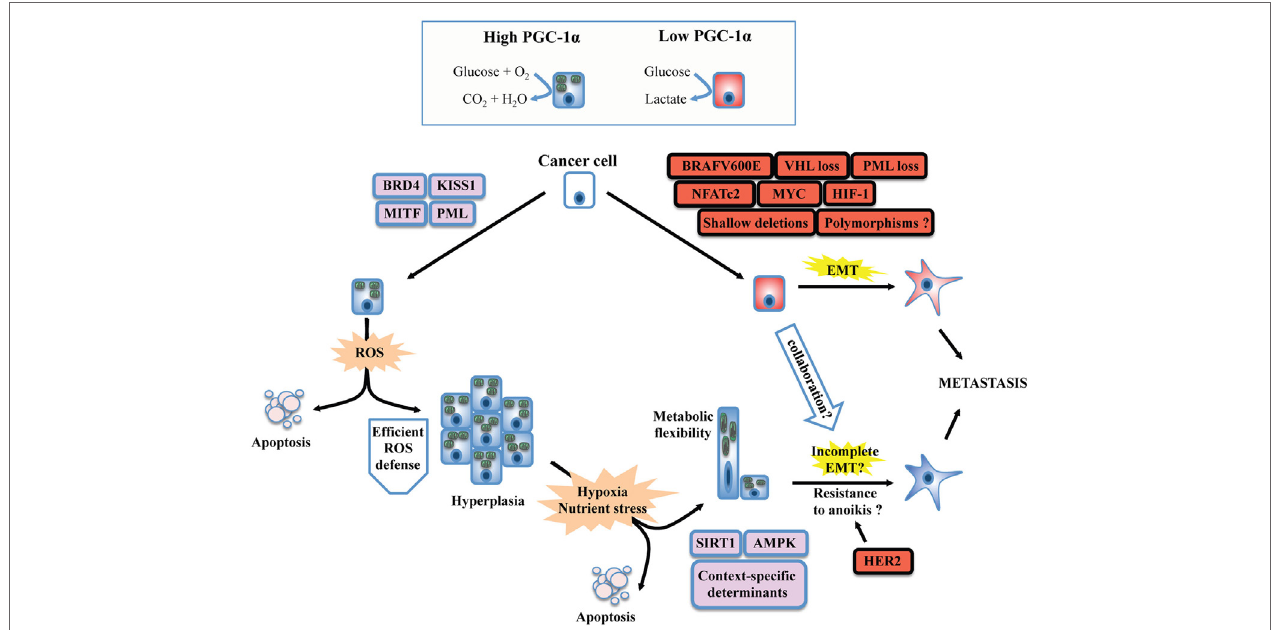
FiGURe 1 | Unifying model for the dichotomous effects of PGC-1 α on tumorigenesis and metastasis. PGC-1 α status usually reflects the metabolic profile of cancer cells. High PGC-1 α will promote mitochondrial metabolism and OXPHOS, while low PGC-1 α is usually associated with increased glycolysis. The switch between glycolytic and OXPHOS status will be the result of a complex interplay between oncogenes, tumor suppressor, and context-dependent determinants such